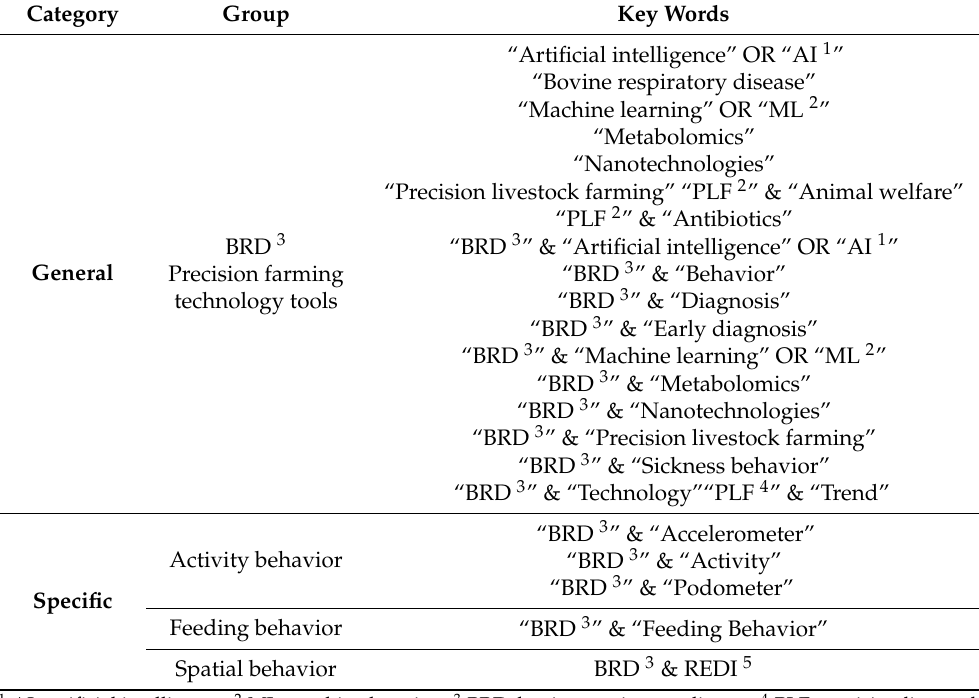
Table 1. Details of the search and keywords used in Google Scholar, PubMed, Scopus and Web of Science (accessed from November 2021 to July 2022). For important topics, full words and their most commonly used abbreviations in the scientific literature were